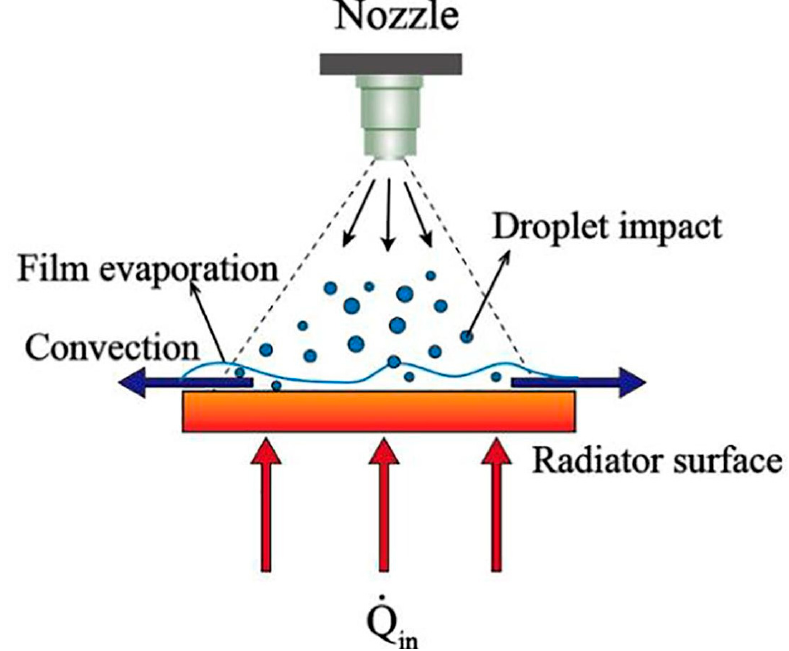
Figure 59. A schematic demonstration of spray cooling process, adapted with permission from Ref. [158]. Copyright © 2022 Elsevier